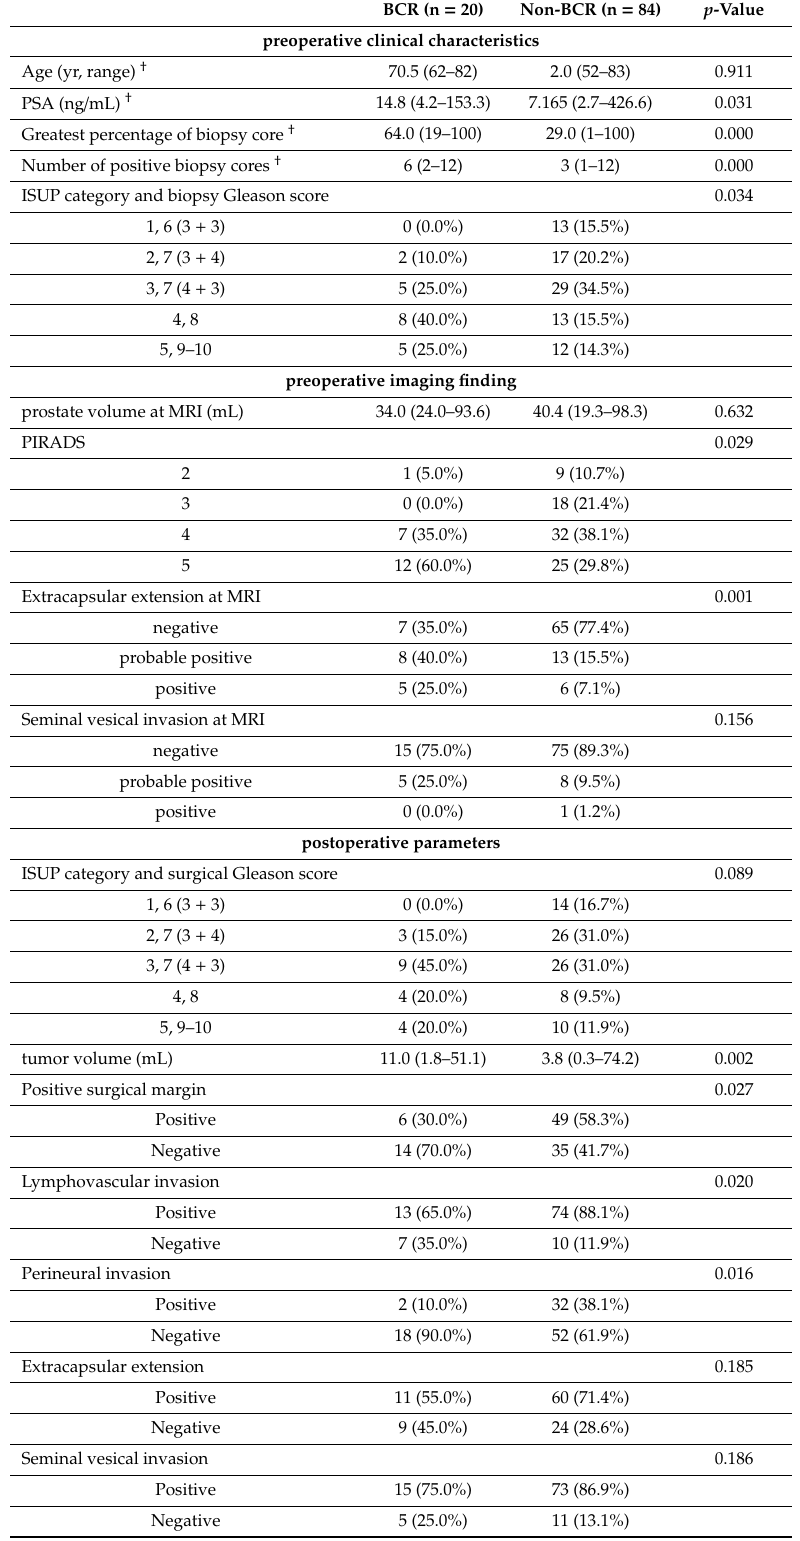
Table 1. Comparisons of clinical, imaging, and pathologic parameters between biochemical recurrence (BCR) and non-BCR